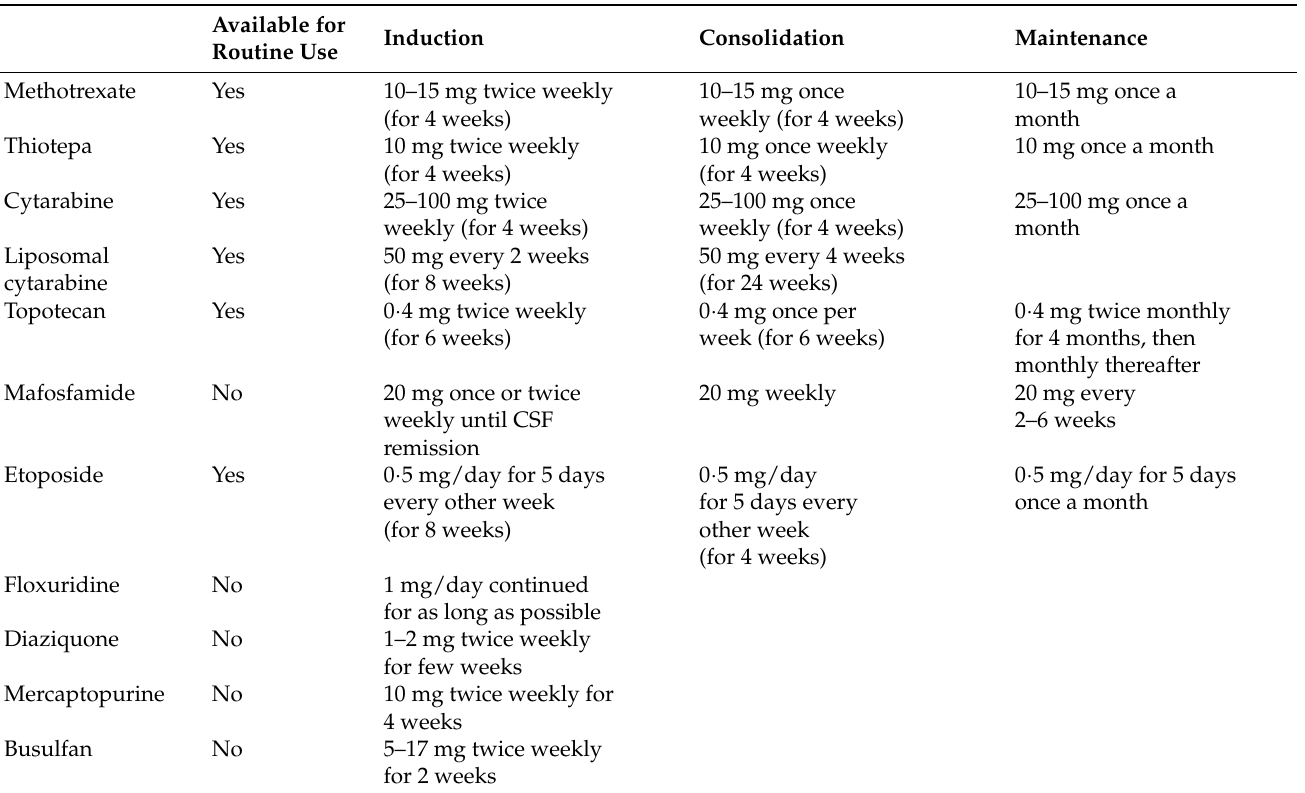
Table 3. Standard and experimental systemic chemotherapy drugs for treatment of neoplastic meningitis. Reproduced with permission from Beauchesne P. Intrathecal chemotherapy for treat- ment of leptomeningeal dissemination of metastatic tumors. Lancet Oncol. 2010; 11(9):